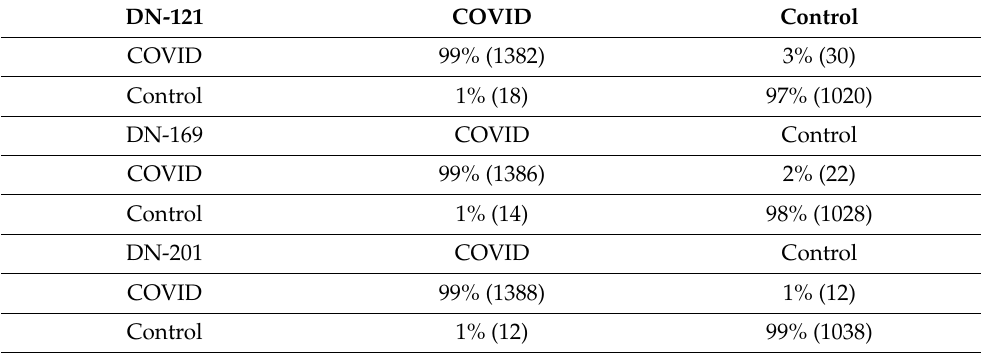
Table 2. Confusion